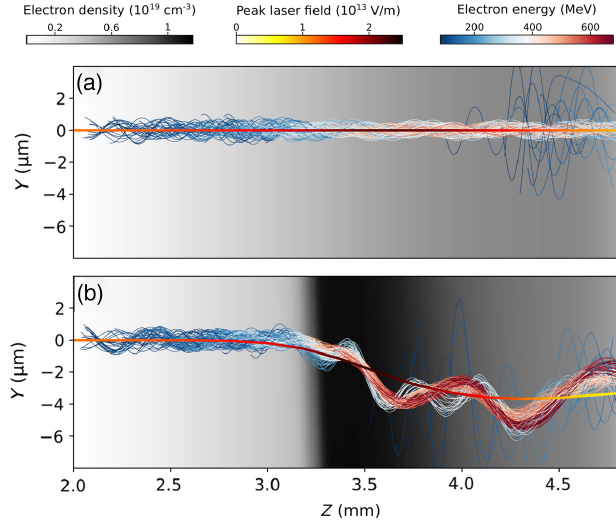
FIG. 6. Particle-in-cell simulations showing the laser propaga- tion (thick curve) and the particle trajectories (thin curves) in ð z; y Þ plane. The orbits are colored according to the laser peak field and the particle energy, respectively. Gray levels represent plasma density. (a) Up-ramp gradient. (b) Up-ramp gradient and transverse density